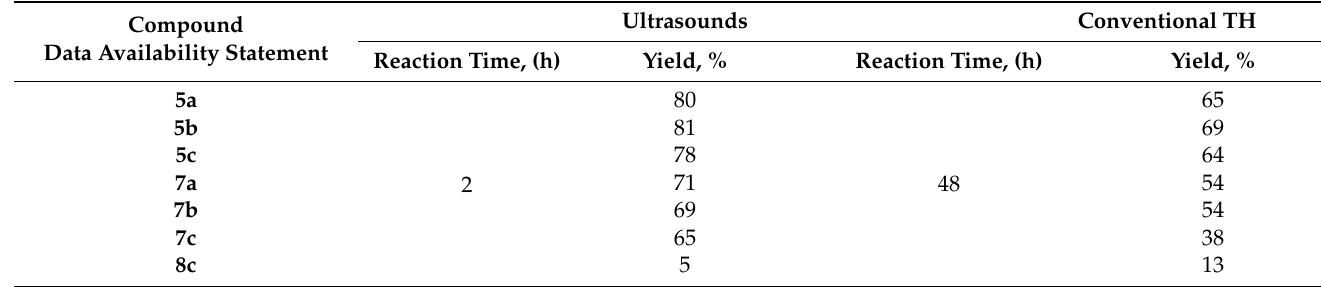
Table 1. The synthesis of azasteroid derivatives under US irradiation and conventional TH. Ultrasounds Conventional TH Compound Data Availability Statement Reaction Time, (h) Yield, % Reaction Time, (h) Yield,